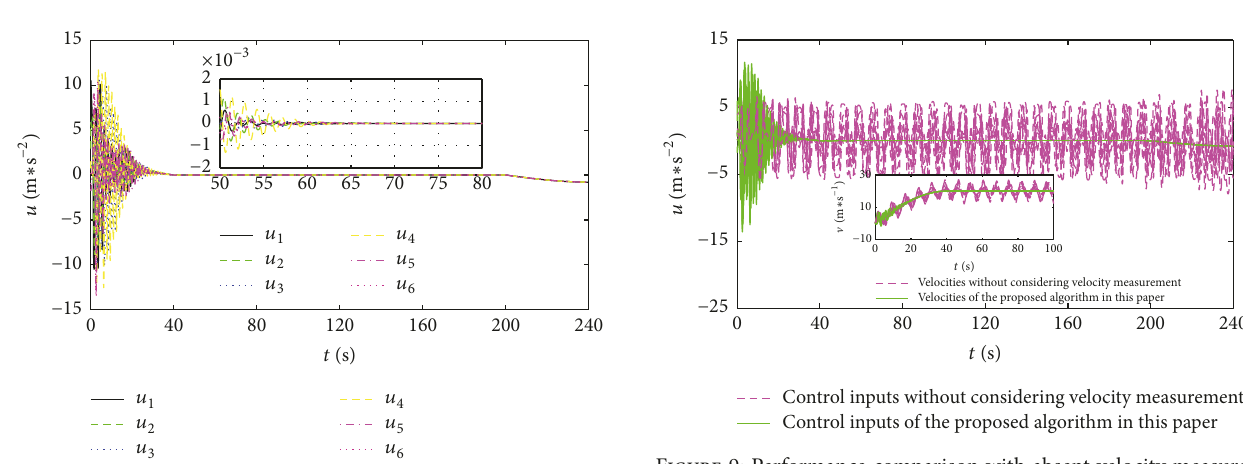
Figure 7: Control inputs of vehicles with actuator saturation and absent velocity measurement.